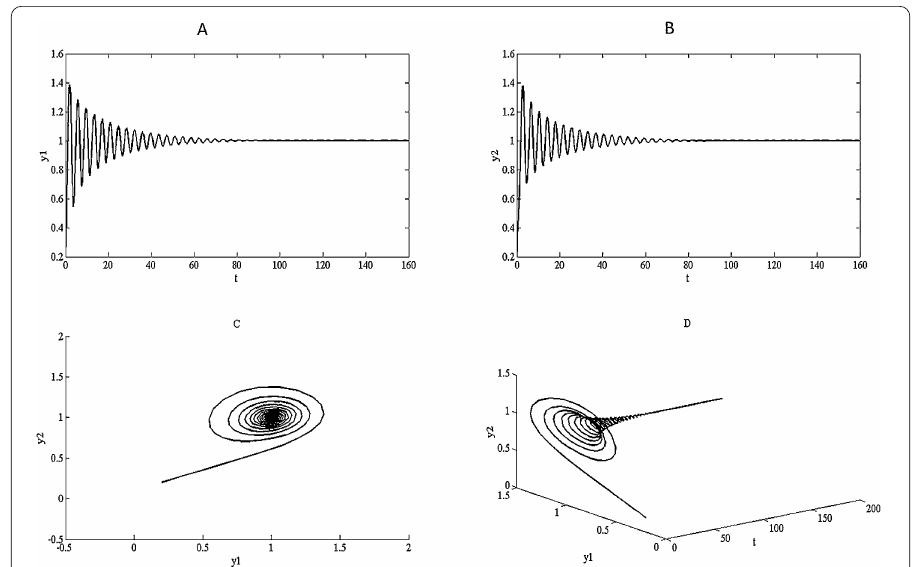
Figure 1 The trajectory graph of system (3.1) with τ 1 = 0.56, τ 2 = 0.56/3, τ 3 = 1.12/3 in ( a ) the t – y 1 plane and in ( b ) the t – y 2 plane. The phase graph of system (3.1) with τ 1 = 0.56, τ 2 = 0.56/3, τ 3 = 1.12/3 in ( c ) the y 1 – y 2 plane and in ( d ) the t – y 1 – y 2 plane